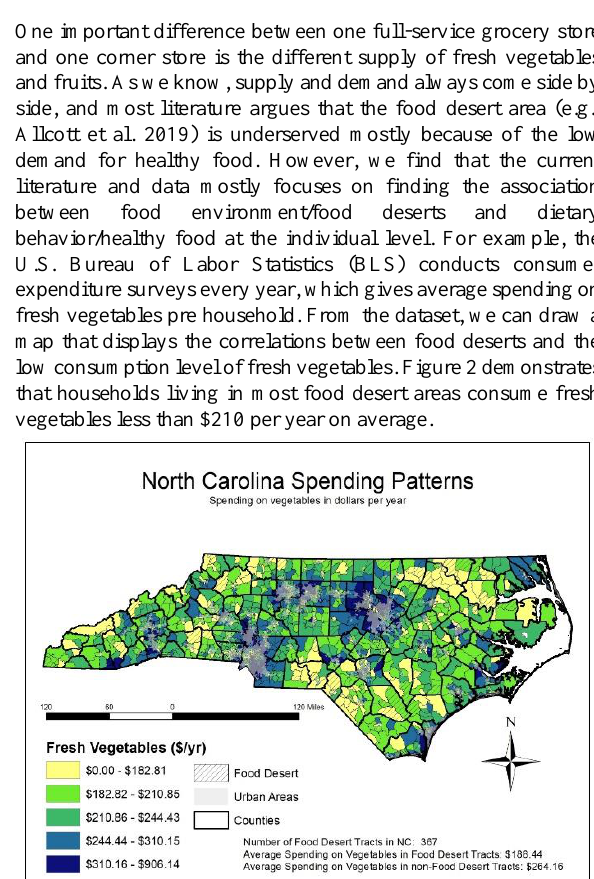
Figure 1b: Food deserts surrounded by undeveloped area/farms (represented by colors other than gray and pink) and households scattered in Guilford County . Data source: USDA food desert mapping, USDA Cropland Data Layer, RTI international's U.S. synthetic household population